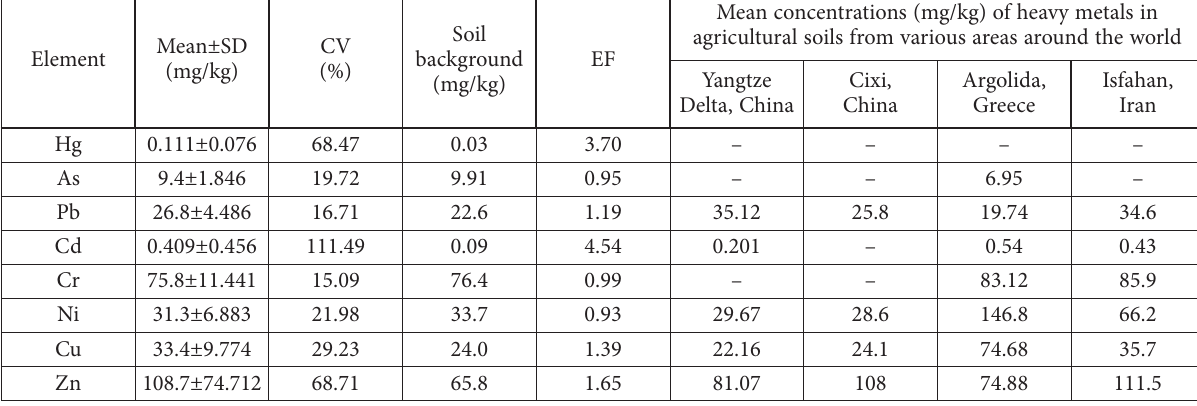
Table 3. Statistical characteristics of heavy metal concentrations in the study area and comparisons with other similar areas